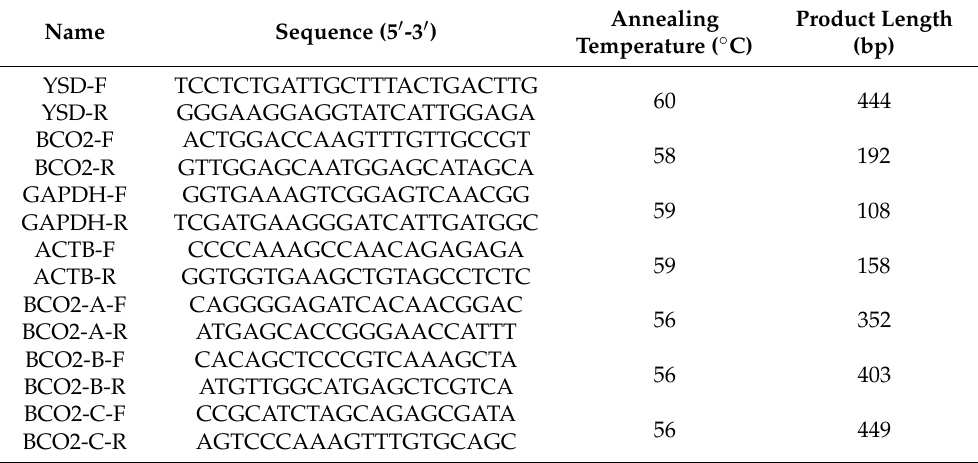
Table 1. The information of the used primers in the